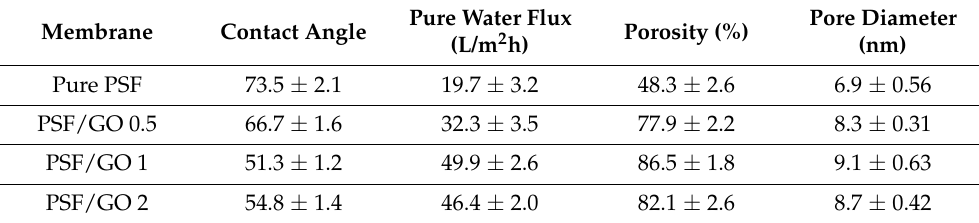
Table 1. Effect of GO content on water contact angle, pure water flux, and pore structure parame- ters of the prepared membranes [139]. PSF—polysulfone; PSF/GO—polysulfone/graphene oxide. Reproduced with permission from ref. [139]. Copyright 2015 Springer.